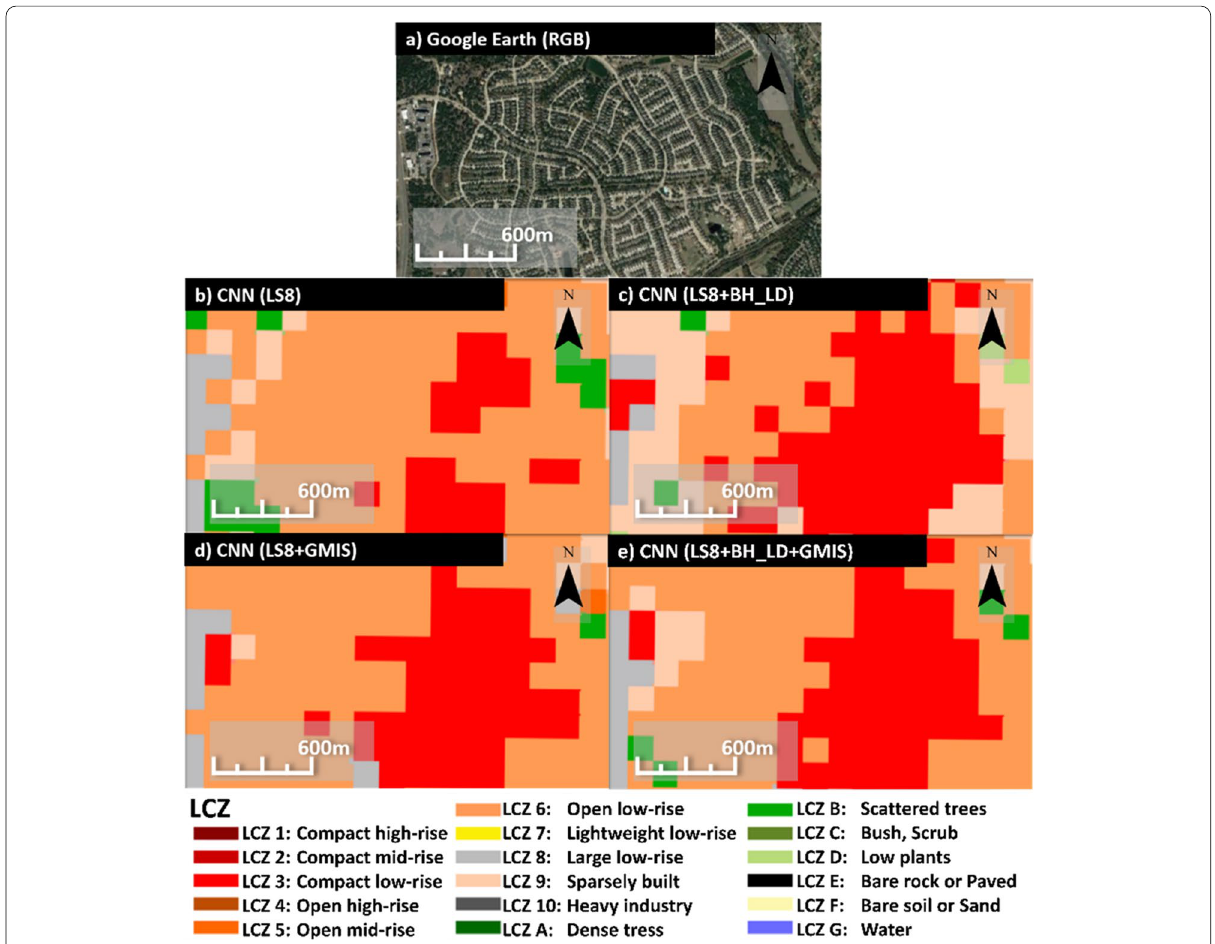
Fig. 11 The a Google Earth image, b CNN with LS8 as input, c CNN with LS8 and BH_LD as input, and d CNN with LS8, BH_LD, and GMIS as input at the eastern Cedar